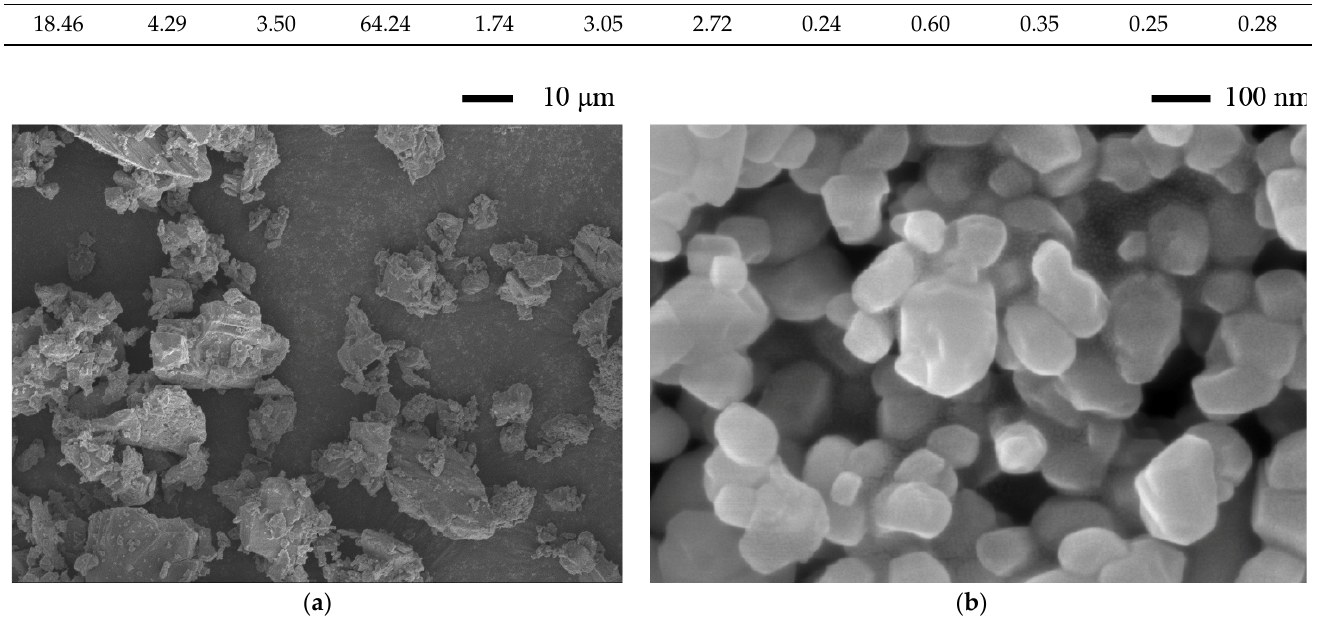
Figure 1. SEM of LS and NC, ( a ) LS, ( b ) NC.